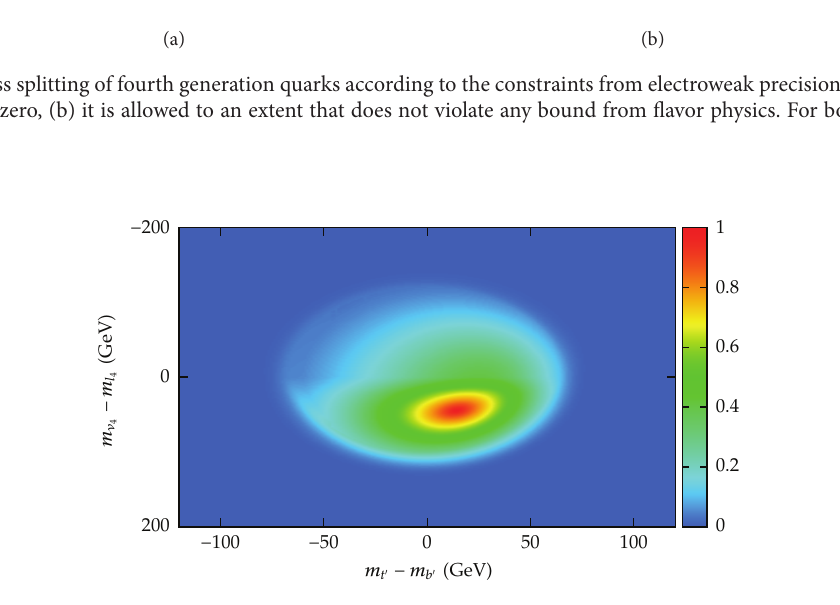
Figure 4: Allowed mass splitting of fourth generation fermions according to the constraints from electroweak precision observables, allowing for CKM mixing and free lepton